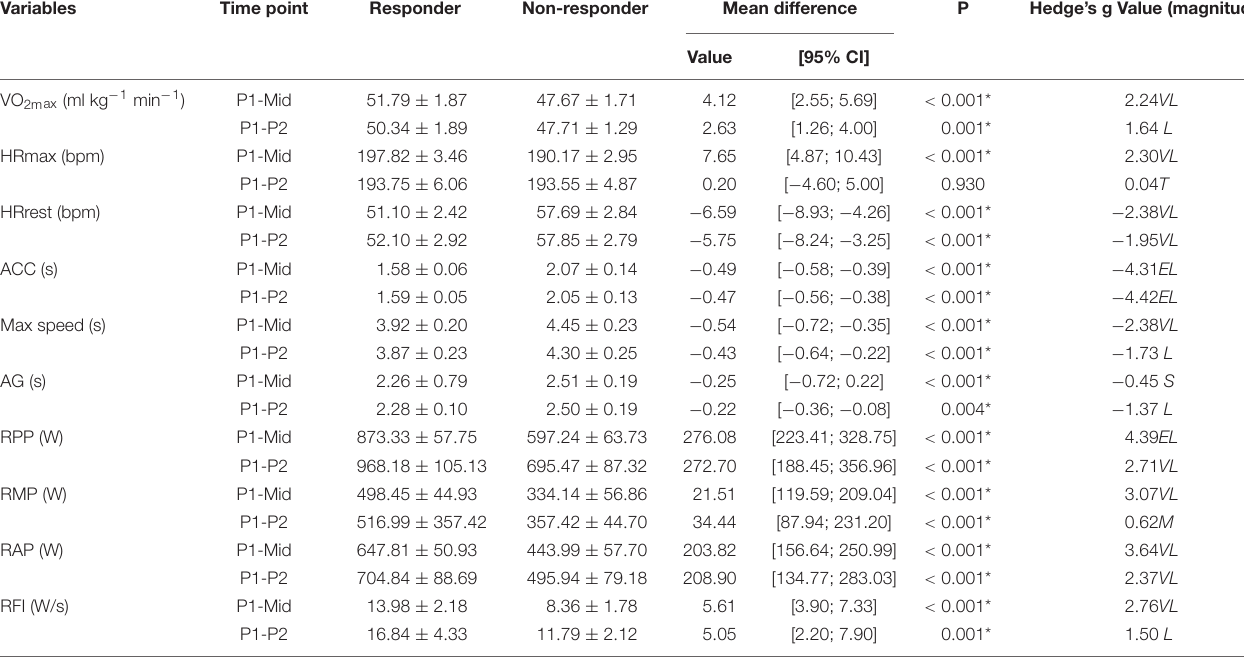
TABLE 5 | Between-group differences of physiological variables (mean ± standard deviation) between responders and non-responders considering the baseline levels.